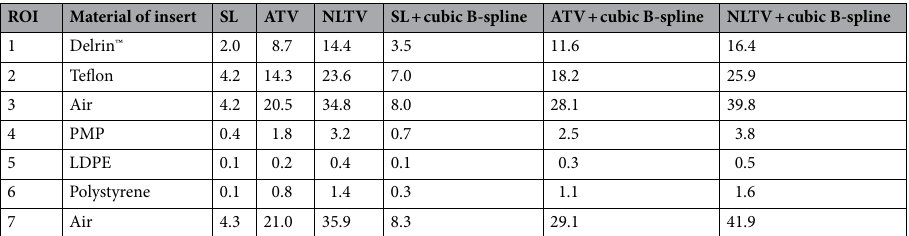
ROI Material of insert